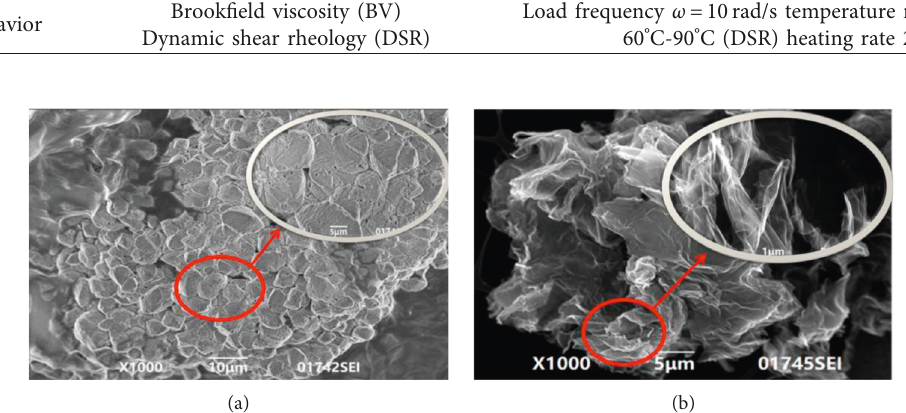
Figure 3: SEM images of GO before and after optimization. (a) Optimized (b) Unoptimized.